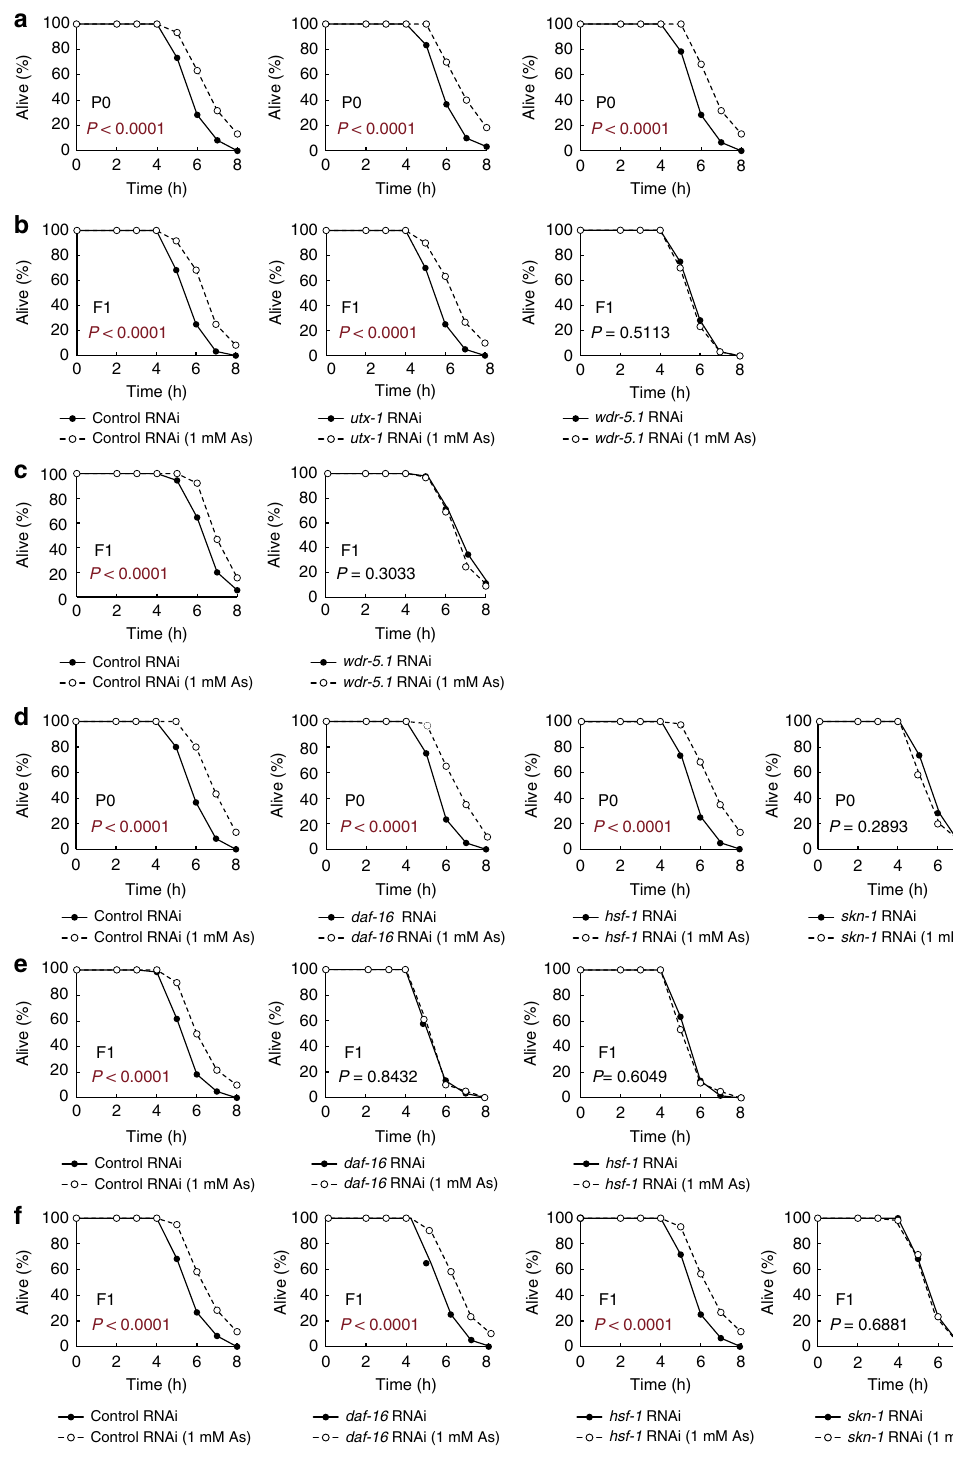
daf-16 RNAi hsf-1 RNAi hsf-1 RNAi (1 mM As) daf-16 RNAi (1 mM As) Figure 4 | The H3K4me3 complex and two transcription factors are required for the transgenerational inheritance. ( a , b ) Oxidative stress resistance (1.7mM H 2 O 2 ) of the stressed P0 parents treated with RNAi (left, empty vector (control); middle, utx-1 ; right, wdr-5.1 ) on day 2 adulthood ( a ) and the self- fertilized F1 descendants on day 1 adulthood ( b ) compared with control groups. Two independent experiments are integrated into each survival curve ( n ¼ 60). ( c ) wdr-5.1 RNAi treatment in F1 descendants from the stressed P0 parents leads to the suppression of the increase in the oxidative stress resistance. Three independent experiments are integrated into each survival curve ( n ¼ 90). ( d , e ) Oxidative stress resistance (1.7mM H 2 O 2 ) of the stressed P0 parents on day 2 adulthood treated with RNAi of indicated genes ( d ) and the self-fertilized F1 descendants on day 1 adulthood ( e ) compared with control groups. ( f ) daf-16 or hsf-1 RNAi treatment performed in the F1 descendants does not compromise the increased resistance, whereas skn-1 RNAi leads to the suppression of the increase in the oxidative stress resistance. Two independent experiments are integrated into each survival curve ( n ¼ 60). P values were calculated by log-rank